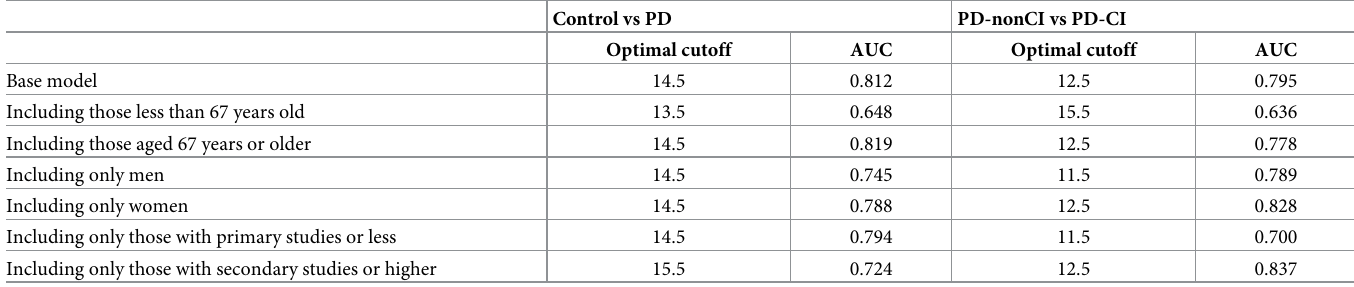
Table 6. Subgroup analysis of the discriminant power of the FAB-E to detect executive dysfunction between healthy controls and PD patients and between PD patients with (PD-CI) and without cognitive deficits (PD-nonCI) by sociodemographic